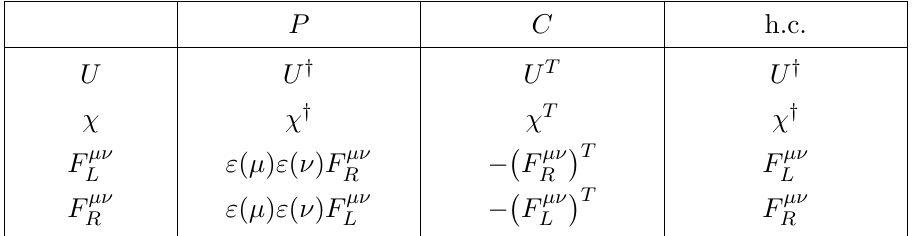
Table 1 . Transformation properties of the (cid:12)rst chiral building blocks. " (0) = (cid:0) " ( i = 1 ; 2 ; 3) =